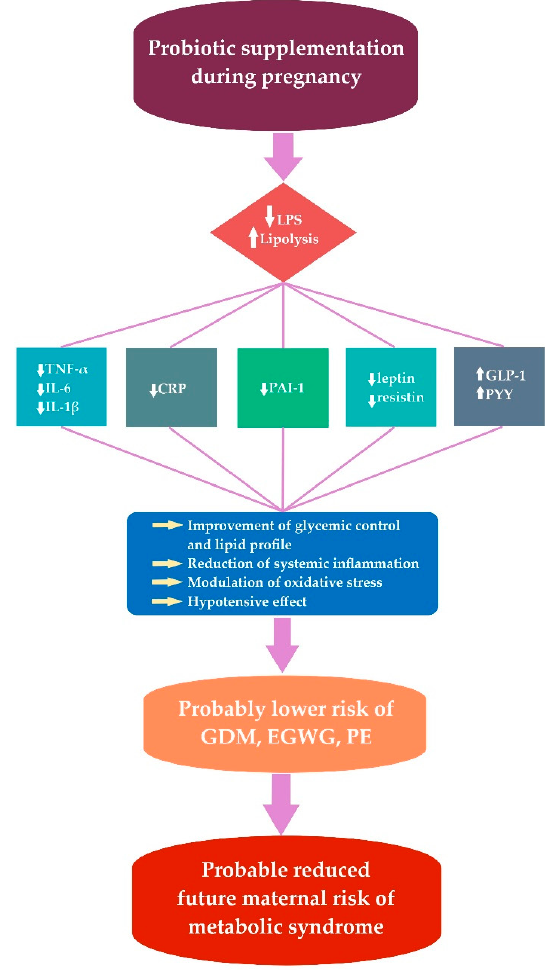
Figure 1. The effect of probiotic supplementation during pregnancy. LPS (lipopolysaccharide); TNF- α (tumor necrosis factor α ); IL-6 (interleukin 6); IL-1 β (interleukin 1 beta); CRP (C-reactive protein); PAI-1 (plasminogen activator inhibitor-1); GLP-1 (glucagon-like peptide 1); PYY (peptide YY); GDM (gestational diabetes mellitus); EGWG (excessive gestational weight gain); PE (preeclampsia).